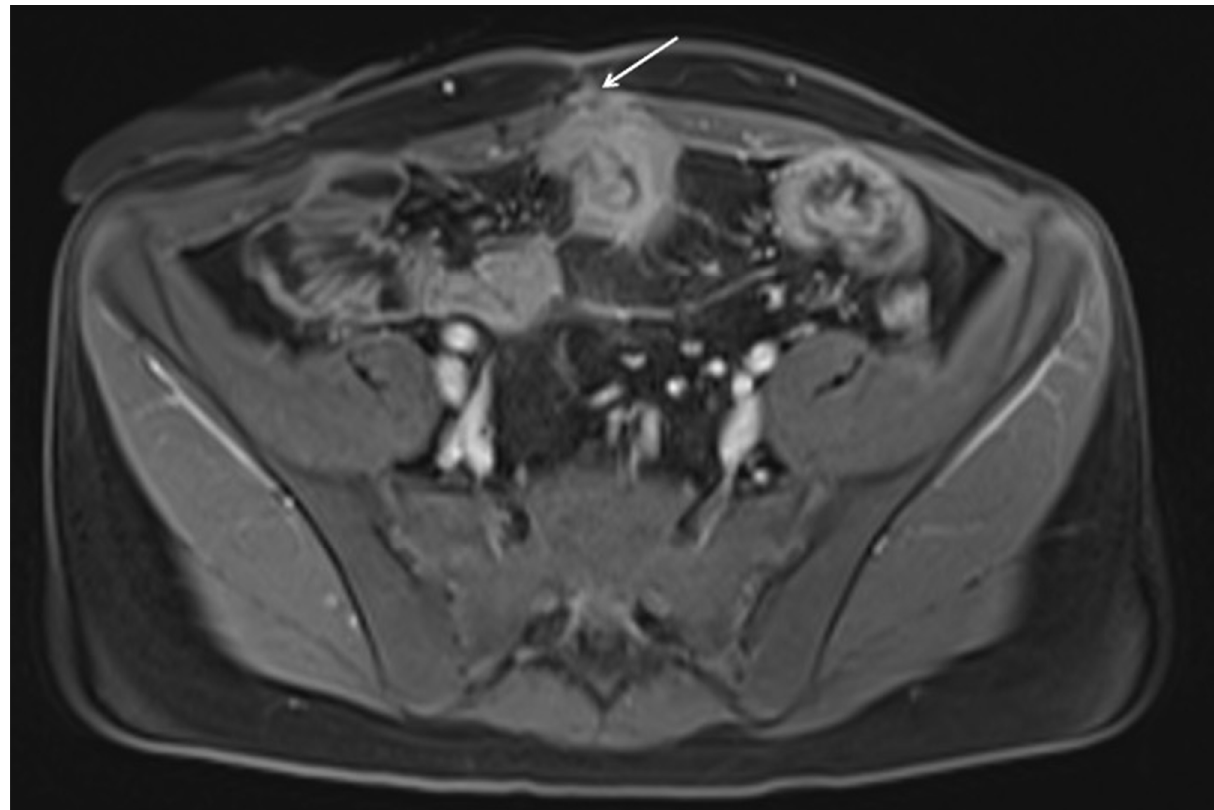
Figure 10. Axial contrast-enhanced fat-suppressed T1 weighted portal venous phase MRE images shows a severe small bowel thickening with an associated enteorcutaneous fistula (white arrows).